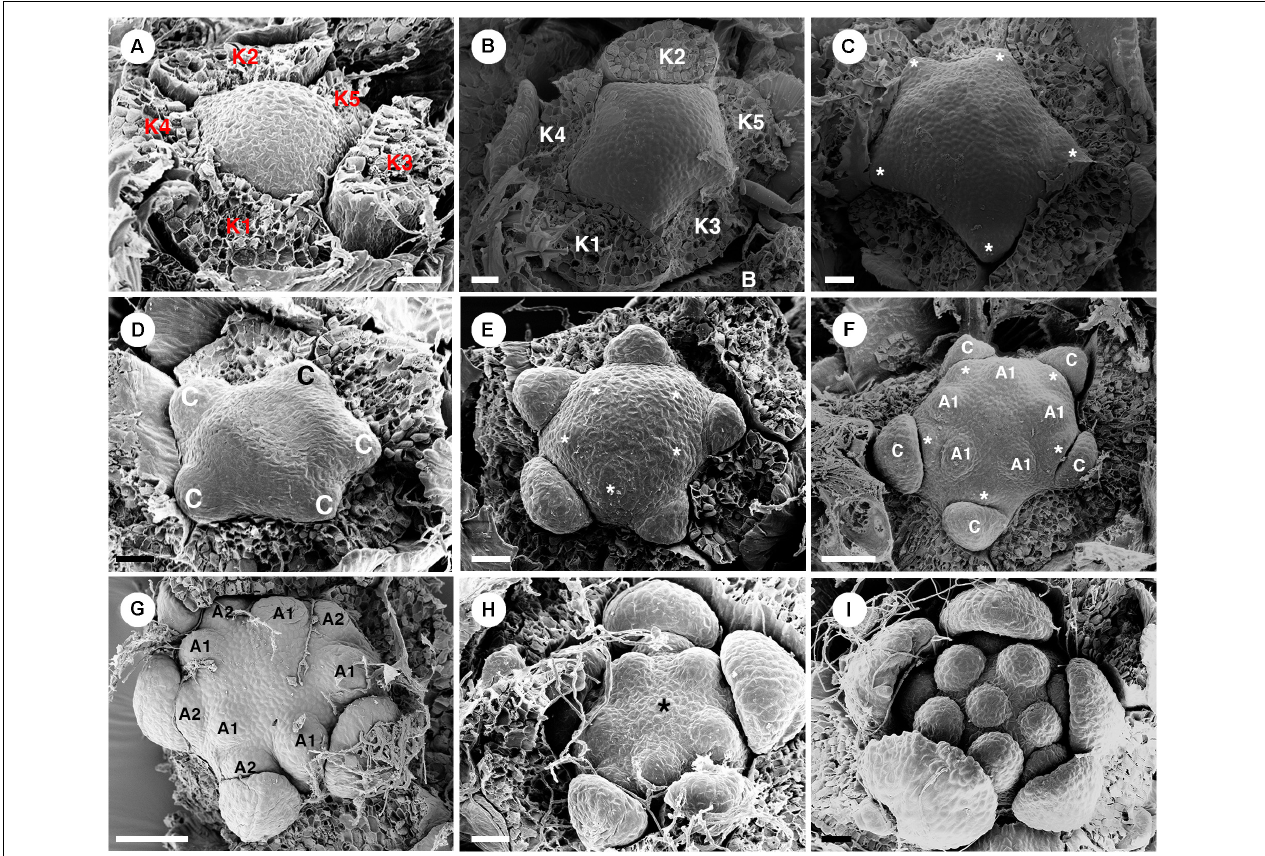
FIGURE 12 | Ontogeny of staminate flowers from Croton schiedeanus . (A) A very young flower bud with five sepals initiating first. The rest of the floral primordium has a convex shape. (B) Apical view of a similar stage; petal primordia start to initiate alternating with sepals. (C) Next, petals grow and expand (asterisk). (D) Petals show a unidirectional growth pattern. (E) Next, the first stamen whorl starts to develop on the convex receptacle alternating with petals (asterisk). (F) Soon, the second whorl of stamens develops centrifugally outside of the first whorl opposite petals. (G) Apical view of slightly older stage, two stamen whorls are visible with the outermost whorl opposite petals. (H) After that, a central stamen starts to initiate on the central empty space (asterisk). (I) Apical view of a young flower shows the completion of stamen development. K, sepal; C, petal; A, stamen. Scale bars: (A–E,I) = 20 µ m; (F,G) = 50 µ m.